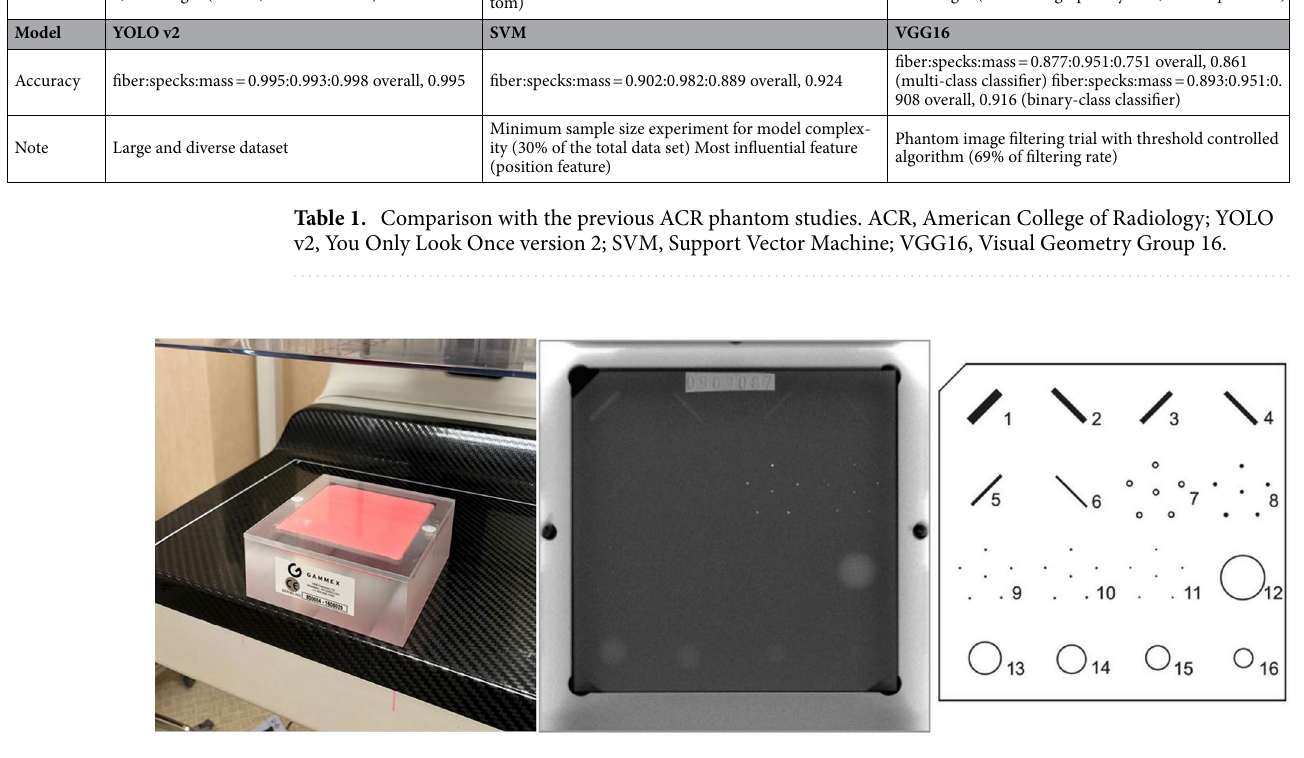
Figure 1. Mammographic accreditation phantom, phantom image, and diagram. American College of Radiology (ACR) phantom (1999 version) containing simulated lesions of 6 fibers, 5 speck groups, and 5